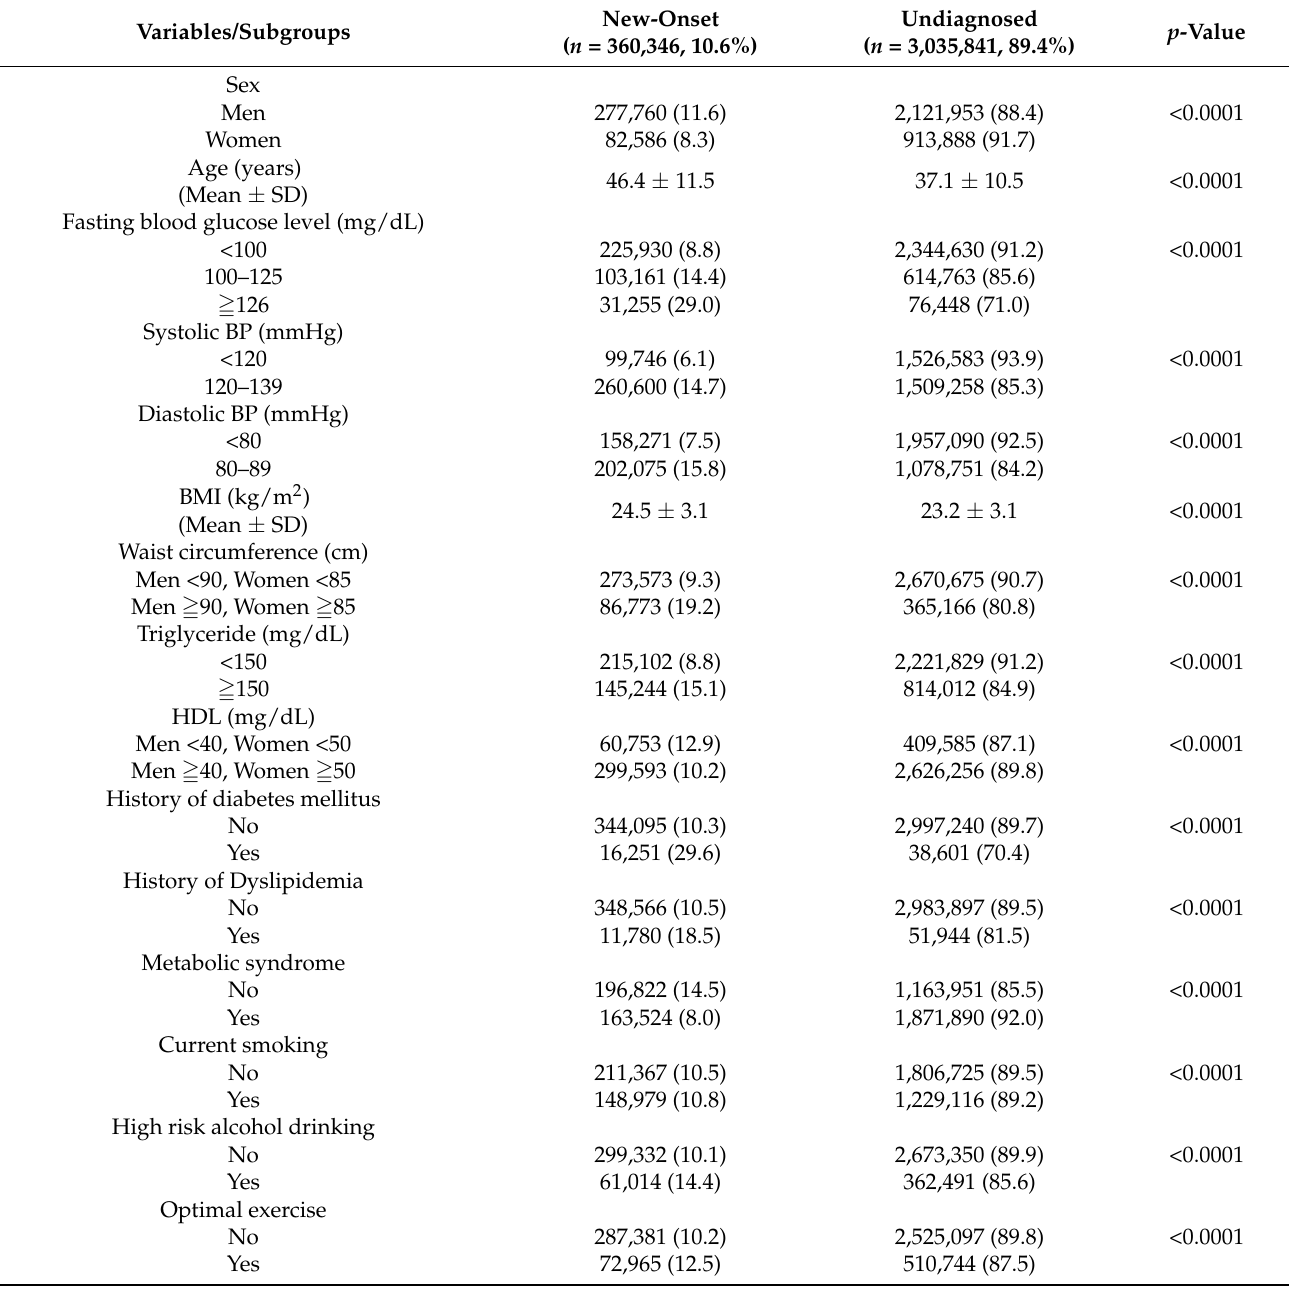
Table 2. Baseline characteristics between new-onset hypertension and non-hypertensive group with the cumulative